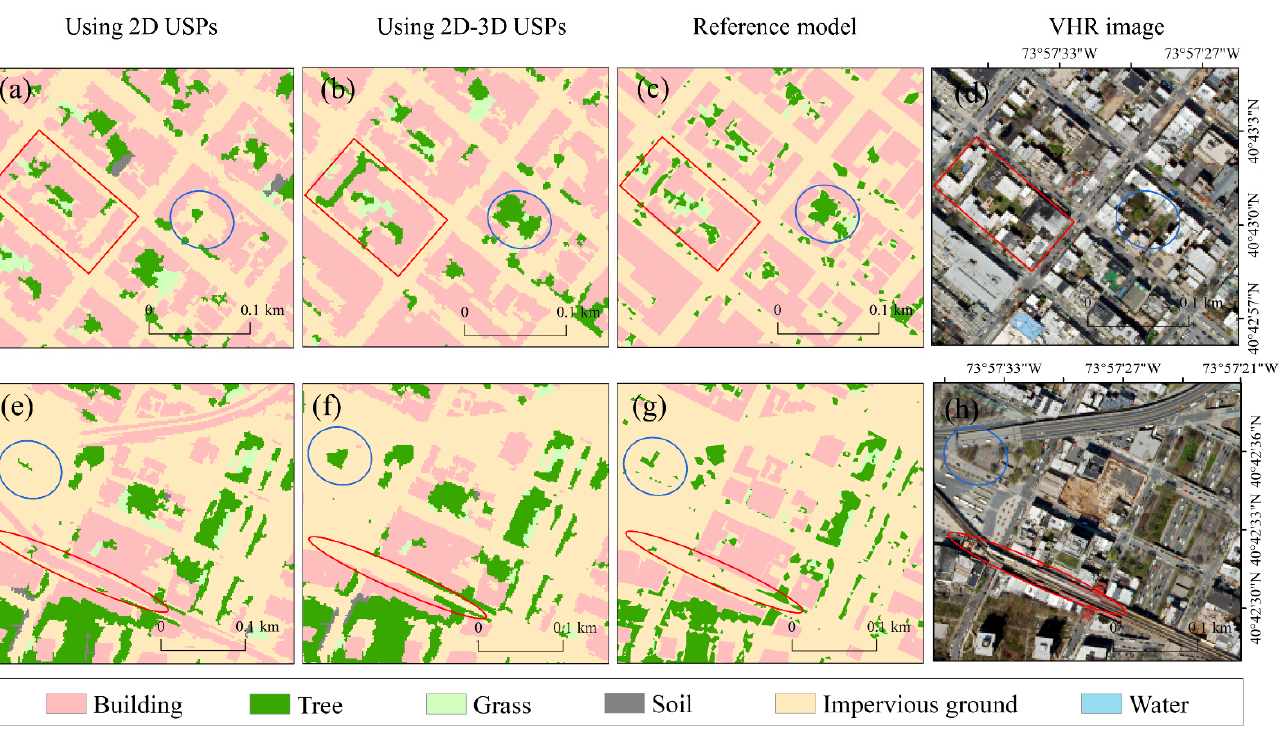
Figure 7. A comparison of classification details of using 2D USPs and 2D-3D USPs. Panels ( a , e ) refer to the classification results using 2D USPs; Panels ( b , f ) refer to the classification results using 2D-3D USPs; Panels ( c , g ) refer to the reference models; Panels ( d , f ) refer to the VHR images.